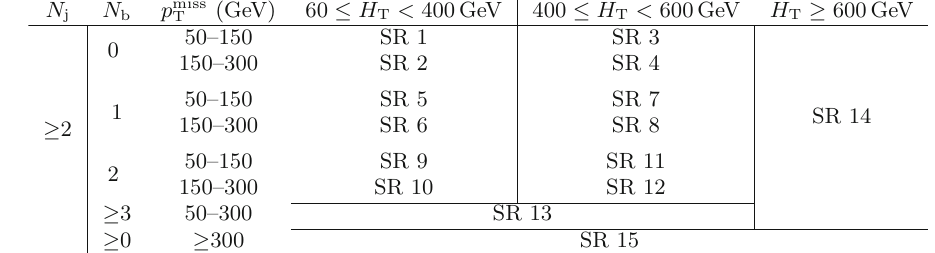
multilepton signal regions. These regions are the same for the on-Z and off-Z